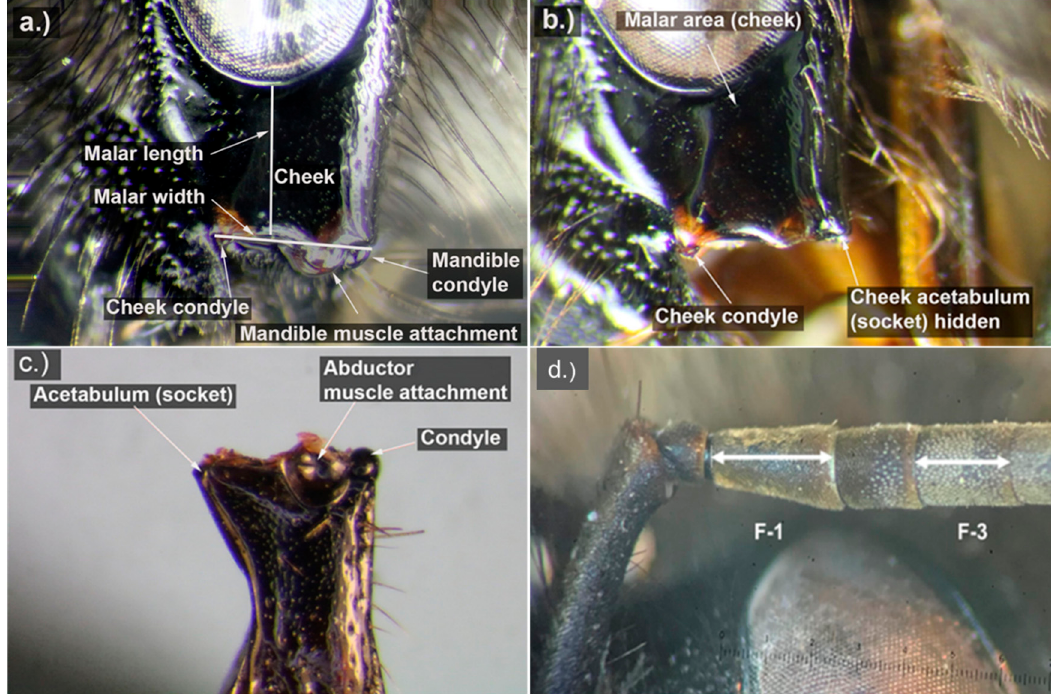
Figure 1. Images of a female Bombus vagans cheek and flagellar segments illustrating the measurement locations for the malar length, malar width, and lengths of flagellar segments 1 and 3. ( a ) Anatomy of the cheek. ( b ) Simplified image of the cheek with the mandible removed to show placement of the cheek condyle and cheek acetabulum. ( c ) Simplified image of the anatomy of the mandible. ( d ) Flagellar segments 1 and 3 illustrating where to make measurements to record length. Photos a-c by Dennis Johnson.